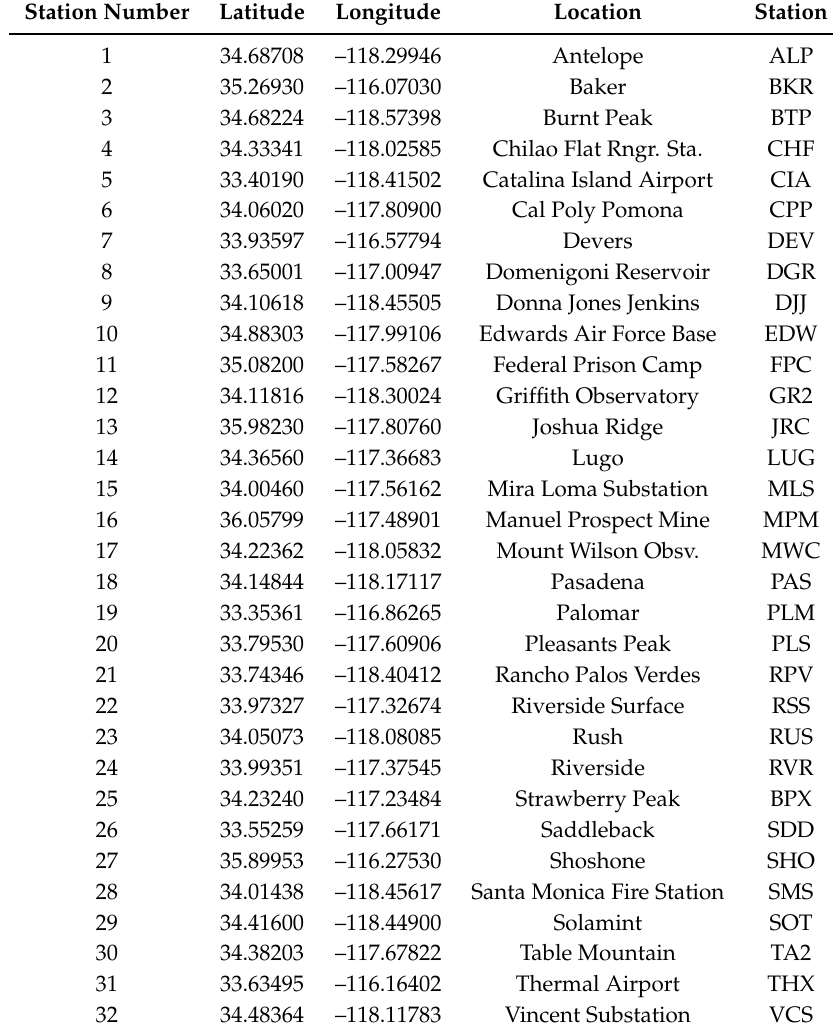
Table A1. List of stations, latitude, longitude, location, and station ID whose data is used for the 1999 Hector Mine earthquake simulation. All stations belong to the Southern California Seismic Network (FDSN code: